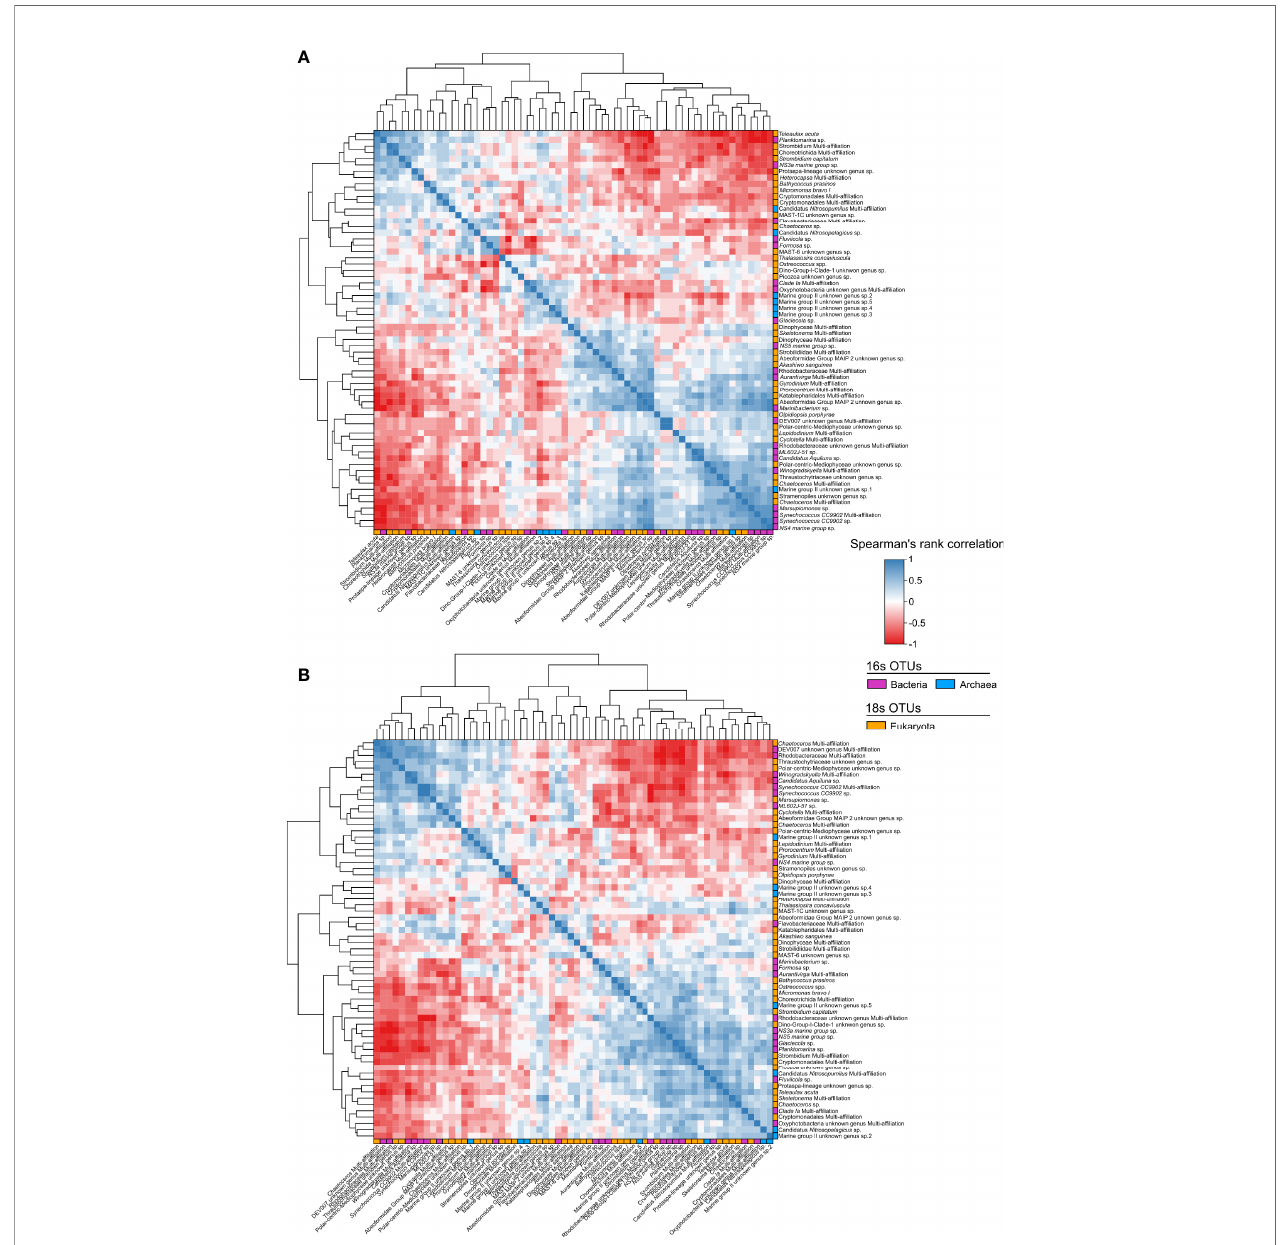
FIGURE 5 | Spearman ’ s rank correlation heatmap of dominant OTUs for 2015 (A) and 2016 (B) . The colour gradient represents the strength of correlations. Blue and red colours represent positive and negative correlations, respectively. Dendrograms are based on hierarchical clustering analysis highlighting dynamic similarities and correlations of taxa that are close to each